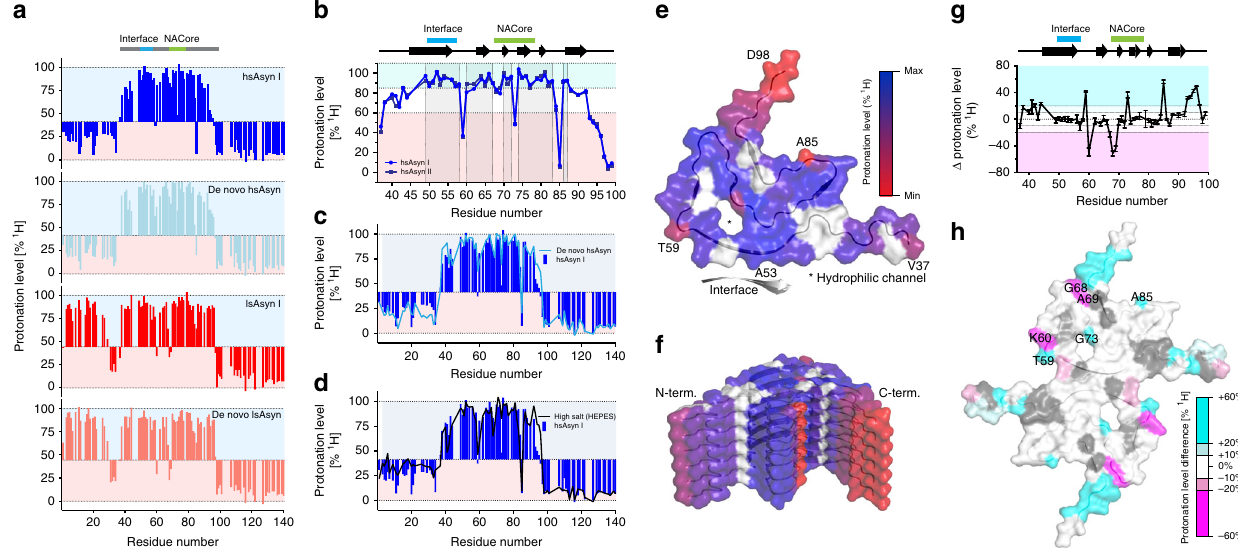
Fig. 4 H/D exchange properties of aSyn in vitro polymorphs. a – d Residue-speci fi c HD-exchange pro fi les of different in vitro polymorphs (see text for further details). e Mapping of residue-speci fi c protonation levels of hsAsyn on the structure of the hsAsyn fi lament (PDB code: 6A6B). The interface to the second fi lament, which involves A53, is marked. The scale bar indicates protonation levels relative to the minimum protonation level observed for V37- Q99. Residues with signal overlap were excluded from the analysis (shown in white). f Side view of ( e ). g , h Residue-speci fi c differences in the protonation levels of hsAsyn and lsAsyn in the region from V37 to Q99 ( g ), mapped in ( h ) onto the core structure of hsAsyn fi brils (PDB code: 6A6B). Difference values were calculated on the basis of the average protonation levels observed for two independently seeded samples (hsAsyn I/II and lsAsyn I/II, respectively). Error bars represent std. NACore is the most hydrophobic part of the aSyn sequence. The interface between two aSyn fi laments as seen in the structure of hsAsyn (PDB code: 6A6B) is